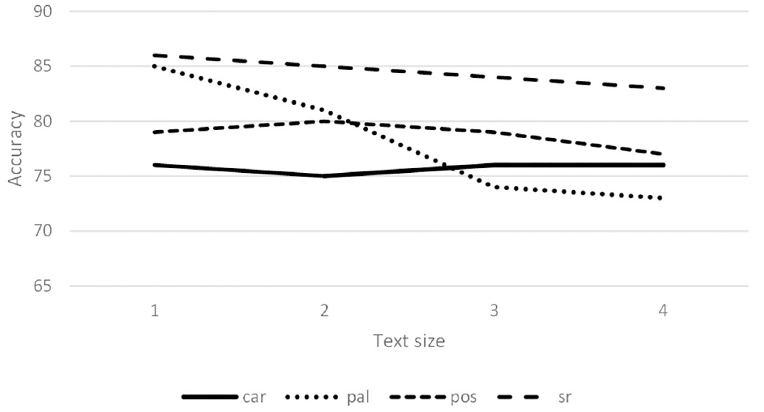
Fig 6. Average of the accuracy (%) using all features.